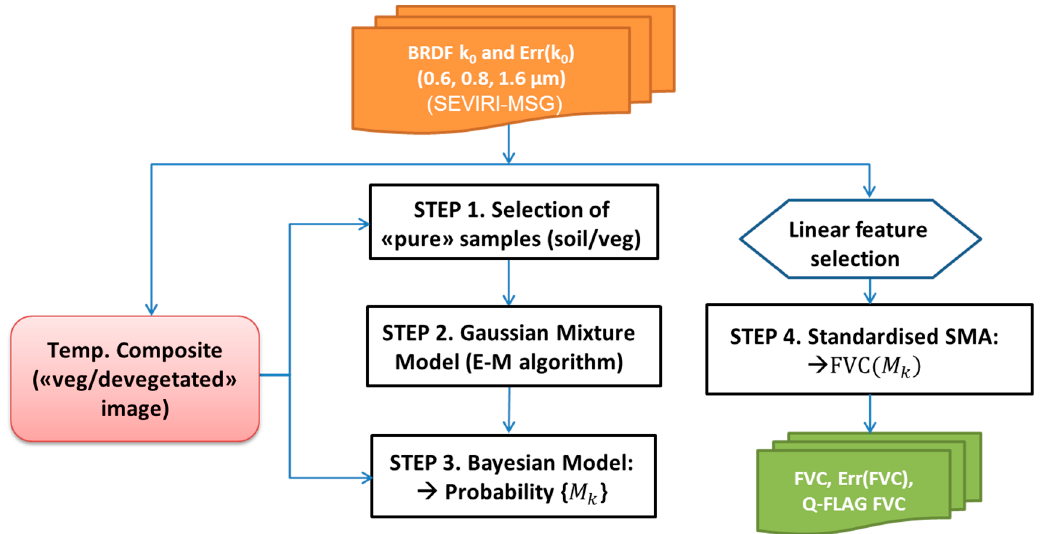
Figure 2. Flow chart of the stochastic SMM algorithm for FVC determination.